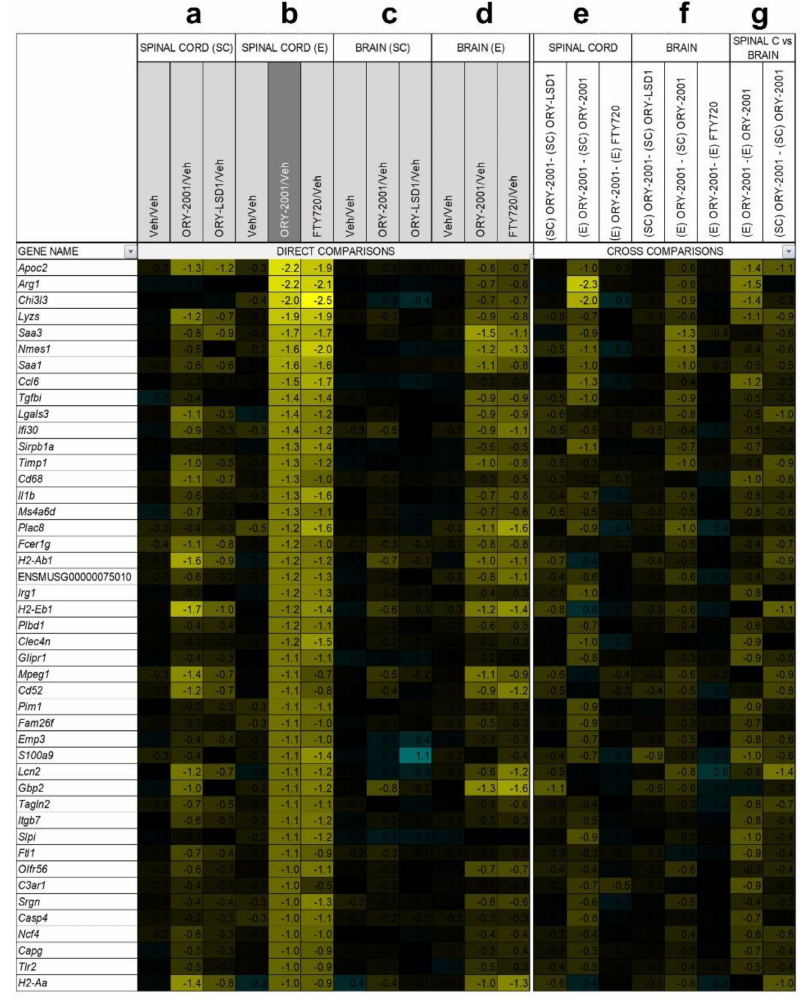
Figure 7. Genes down-regulated by ORY-2001. Microarray survey of gene expression changes in the spinal cord ( a ) and in the brain ( c ) in the sub-chronic phase (SC) 3 days after the last dose. Animals were treated with vehicle (Veh), ORY-2001 (0.5 mg/kg) or ORY-LSD1 (180 µ g/kg). Microarray survey of gene expression changes in spinal cord ( b ) and in the brain ( d ) in the effector phase ( e ) 24 h after treatment. Animals were treated with vehicle, ORY-2001 (0.5 mg/kg) or FTY720 (1.0 mg/kg). Cross comparison of the effect of the different treatments and disease phases in the spinal cord ( e ) and in the brain ( f ); ( g ) Cross comparison of the effects of ORY-2001 in spinal cord and brain, in both phases. Pooled RNA from N = 5 spinal cords, 10 brains of vehicle, ORY-2001 or ORY-LSD1-treated mice or from N = 4 spinal cords, 6 brains of FTY720-treated mice was used to perform each survey, n = 3 replicate probes within an array. Gene expression changes are expressed as Log 2 (Treatment/Veh) for direct comparisons, and as the difference of the Log 2 (Treatment/Veh) values for the respective conditions in the cross-comparisons. Genes down-regulated > 2-fold (Log 2 (ORY-2001/Veh) < − 1) by ORY-2001 in the spinal cord in the effector phase were selected and represented for all